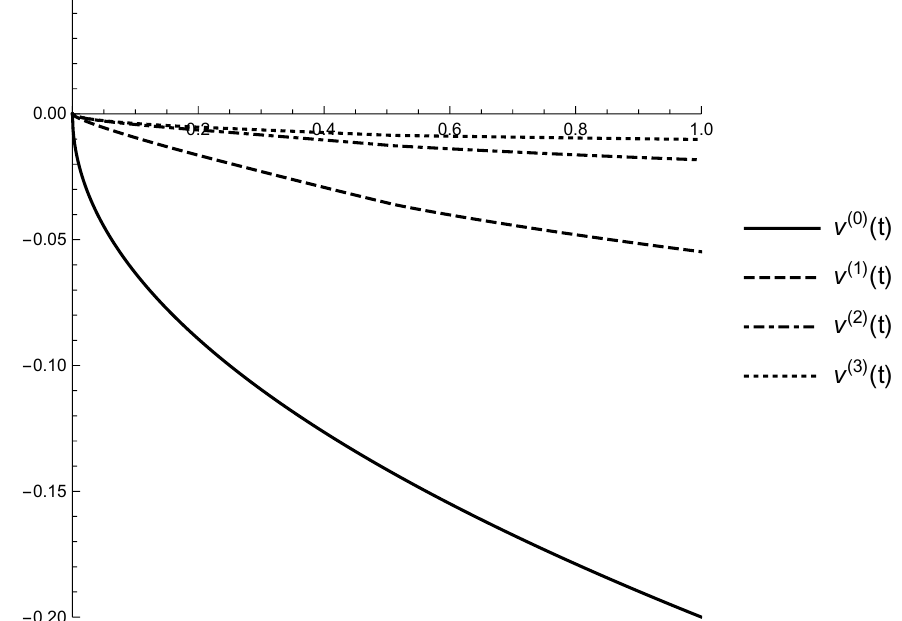
Figure 4. Graphs of the successive lower approximations v ( n ) ( t ) , n = 0, 1, 2, 3, on the interval [ 0,1 ]